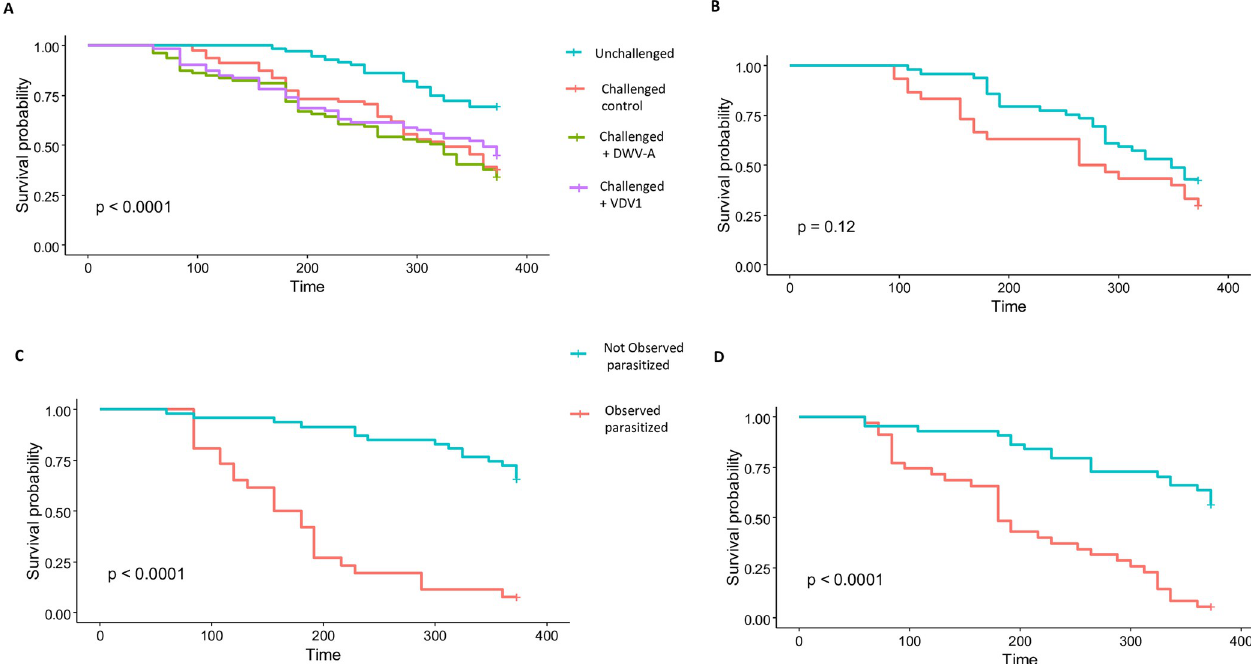
Fig 4. Survivorship of parasitized and non-parasitized bees : A . Survival analysis of bees from all treatment groups in the trial. B, C, D Survival analysis of parasitized and non-parasitized bees within each challenged trial group. B. Survivorship analysis of challenged control bees. C . Survivorship analysis of challenged + DWV bees. D. Survivorship analysis of challenged + VDV1 bees. There was a significant difference in survivorship between parasitized bees in the challenged + virus groups ( p < 0.0001) but not in the challenged control group ( p =